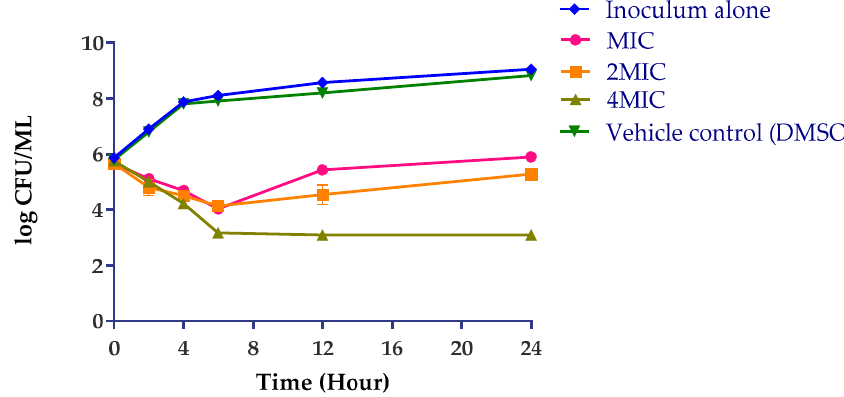
Figure 3. Antibacterial efficacy testing of P. huayllabambana n-hexane fraction on S. enterica . Time intervals: 0, 2, 4, 6, 12, and 24 h. Data are expressed as mean ± SD ( p < 0.05). MIC: minimum inhibitory